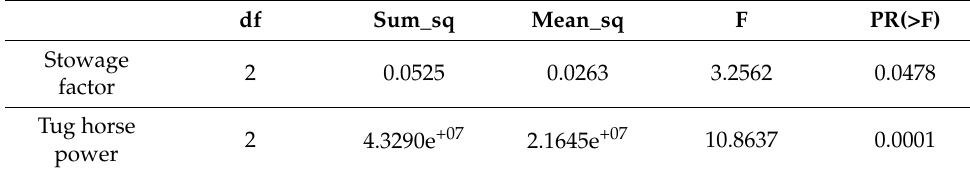
Table 11. Results of ANOVA.